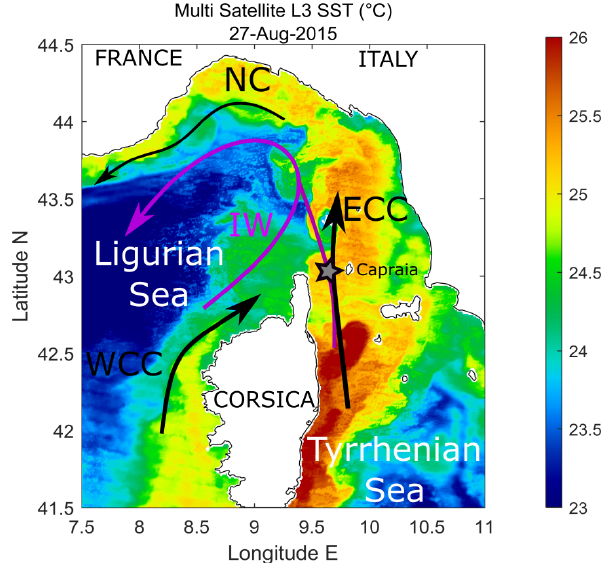
Figure 1. Map of the area. Main current features (ECC: East- ern Corsica Current; WCC: Western Corsica Current; NC: North- ern Current; IW: Intermediate Water pathway) and the position of the moored ADCP (star) are indicated. In the background (colour coded), the sea surface temperature (SST) field from a sample day (27 August 2015, ◦ C) is provided to highlight the mesoscale and frontal systems (source